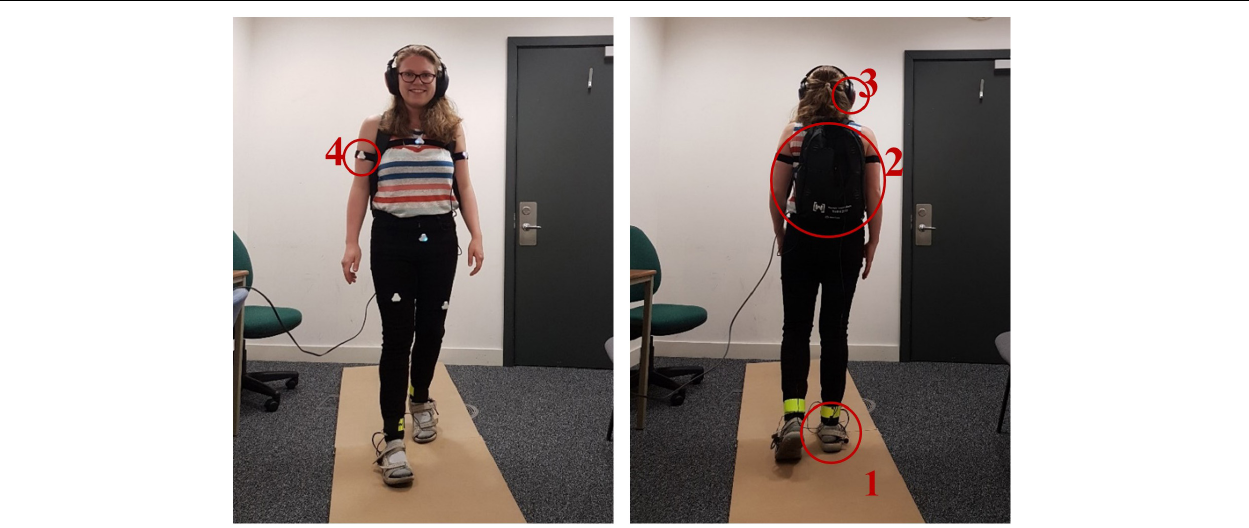
FIGURE 1 | Equipment during the two walking phases. Participants wore strap-sandals with attached microphones (1), a small backpack containing a preamplifier and an equaliser (2), and headphones through which participants heard their altered footstep sounds (3). Black rubber bands with one of six Notch movement sensors (white triangles) each (4) were attached to the upper arms, chest, hip, and